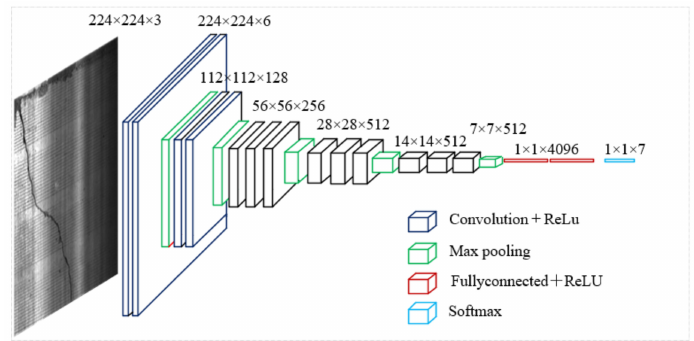
Figure 8. Visual geometry group network-16 (VGG-16) transfer learning